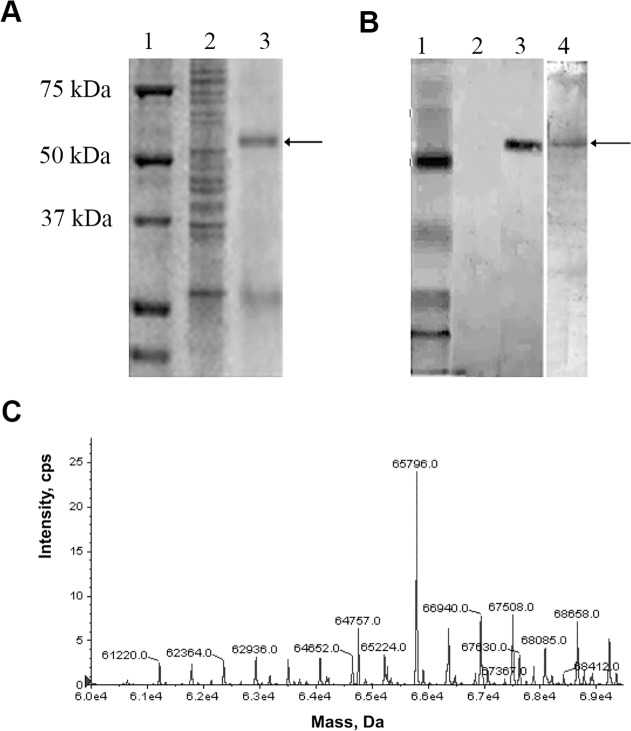

Pvs48/45 protein expression in E. coli.
A. 10% SDS-PAGE stained with Coomasie blue. Lane 1, molecular weight marker; lane 2, un-induced cells total extract; lane 3, purified Pvs48/45 under reducing conditions (10mM β-mercaptoethanol). B. Western blot of Pvs48/45. Lane 1, molecular weight marker; Lane 2, un-induced cells total extract under reducing conditions (10mM β-mercaptoethanol). Lane 3, Pvs48/45 revealed against anti-His antibody; Lane 4, Pvs48/45 revealed against hyper-immune monkey sera. Arrows indicate the expected weight. C. Mass spectrum of Pvs48/45.